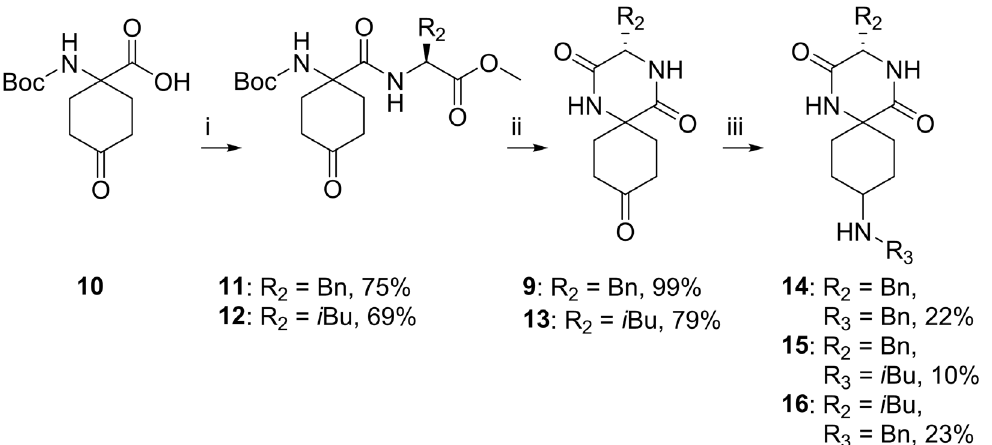
Fig 5. Synthesis of spiro-DKPs 9 – 16. Reagents and reaction conditions: i) AA-OMe (1.5 – 1.7 eq.). HATU (2.0 eq.), DIPEA (6.0 eq.), DMF, 60°C, 30 min. ii) water, MW, 160°C, 70 min. iii) R 3 -NH 2 (1.7 – 2.0 eq.), PEMB (1.0 eq.), glacial acetic acid (2.3 – 2.6 eq.), MeOH, r.t. o.n.